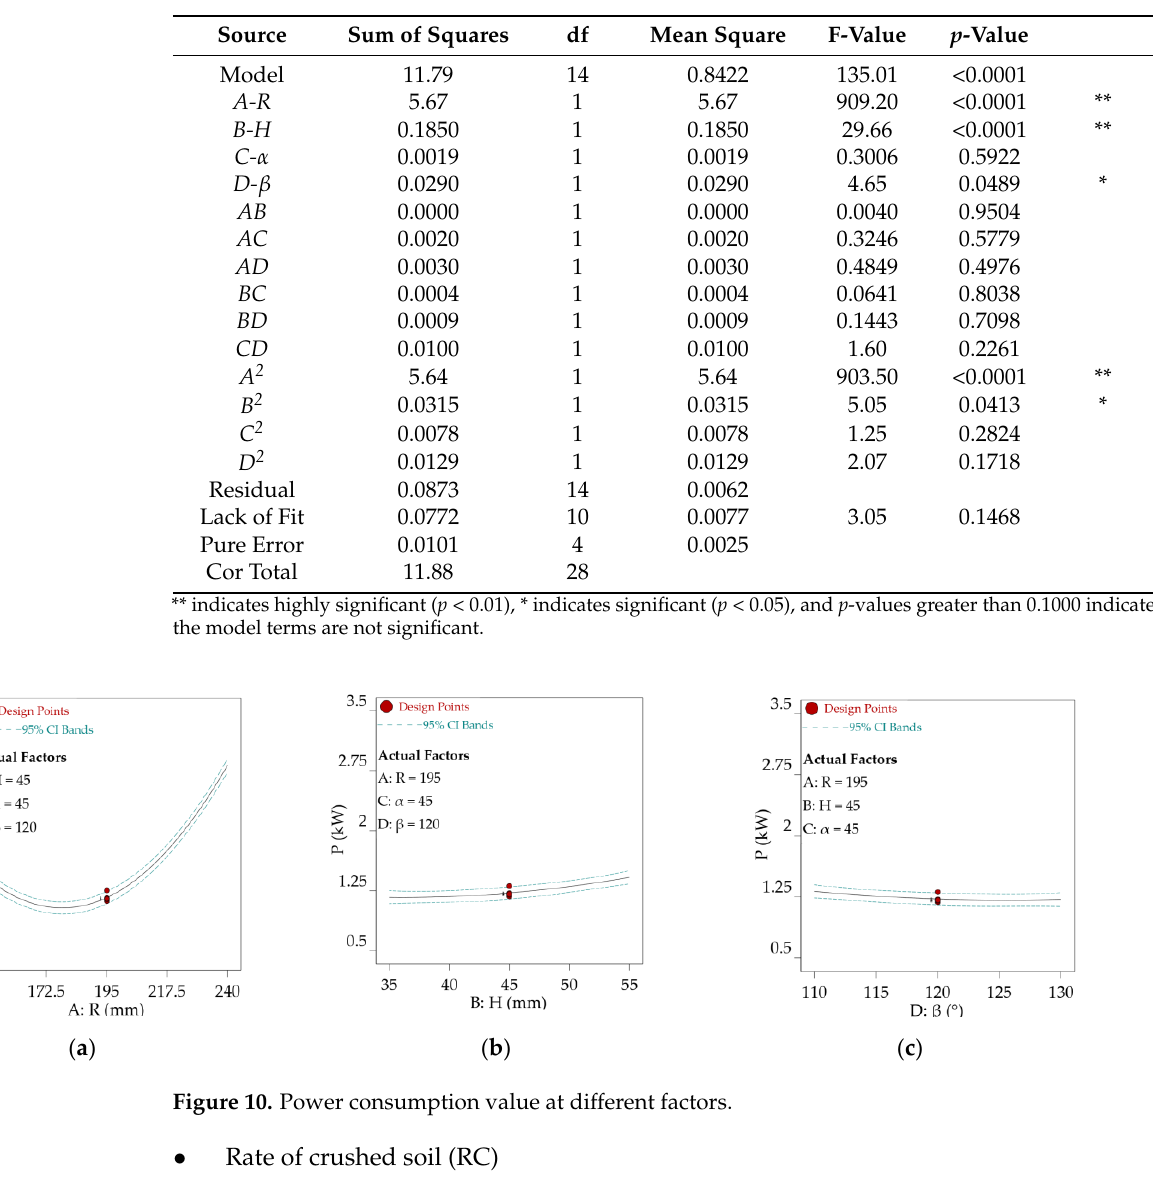
Table 7. ANOVA for Quadratic model of Power.